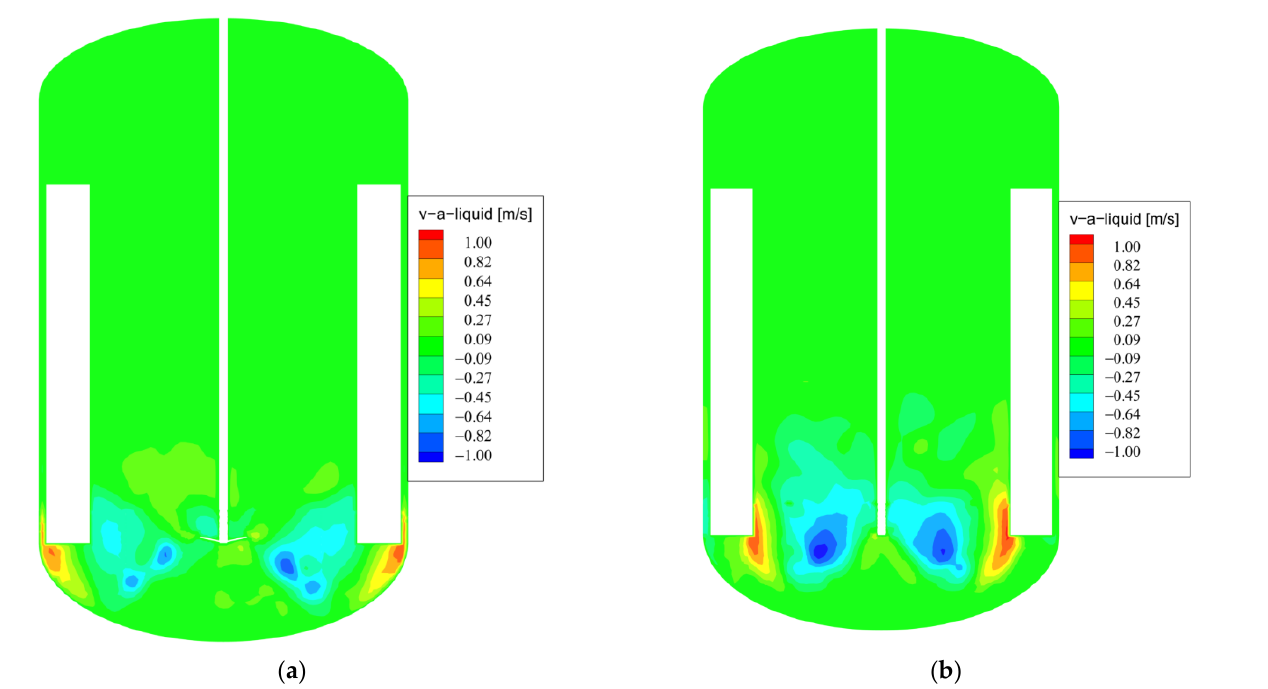
Figure 7. Axial velocity distribution of the liquid phase: ( a ) flow started from the solid phase fully sedimented; ( b ) flow from the solid phase dispersed in the entire volume of liquid.